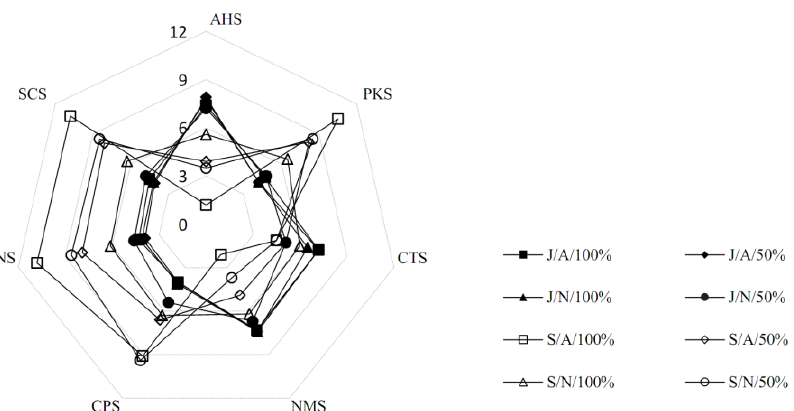
Figure 5. Comparative analysis of electronic tongue-based taste patterns in vinegar. According to fermentation conditions, the taste pattern of bokbunja vinegar was analyzed using an electronic tongue. Seven types of sensors were used for the analysis: AHS indicates sour taste, CTS indicates salty taste, NMS indicates umami, ANS indicates sweet taste, and SCS indicates bitter taste. It was analyzed that vinegar fermented in a jar had a sour and umami taste, while vinegar fermented in a stainless steel container had a bitter and sweet taste.